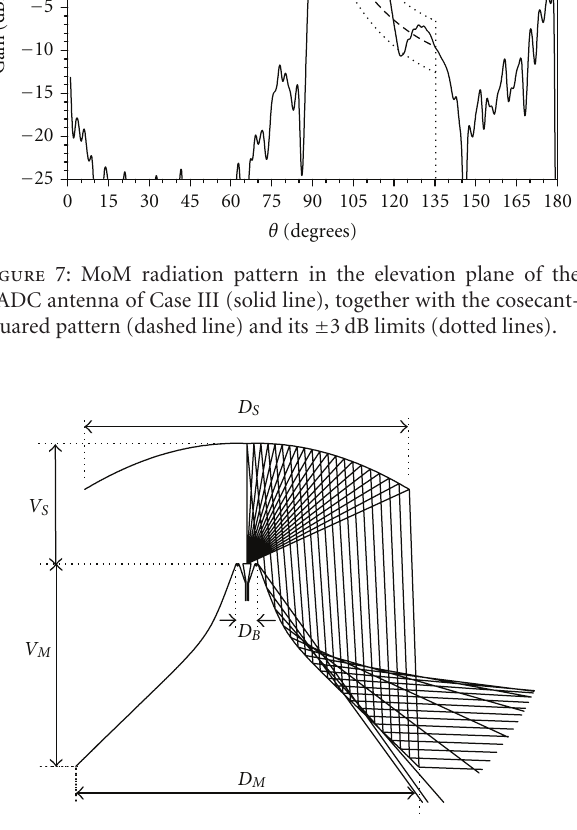
Figure 8: Sub- and main-reflector generatrices of the Case IV OADC